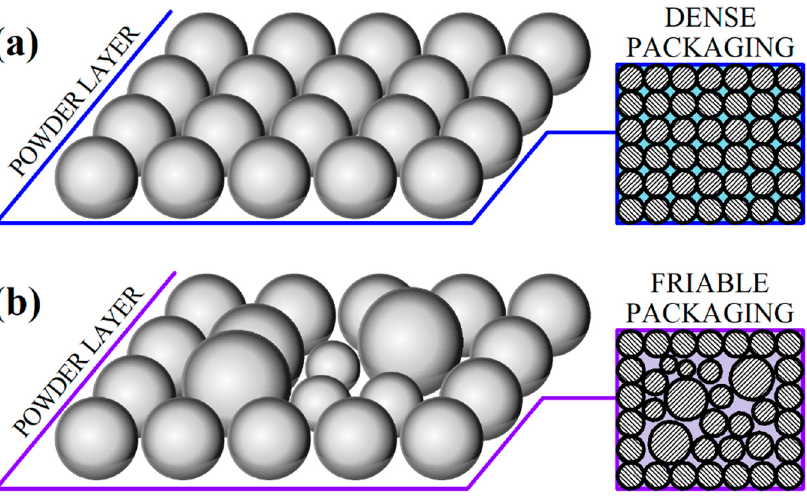
Figure 1. Formation of the powder building layer: ( a ) powder with a narrow particle size distribu- tion; ( b ) powder with uneven particle size distribution. ( b ) powder with uneven particle size